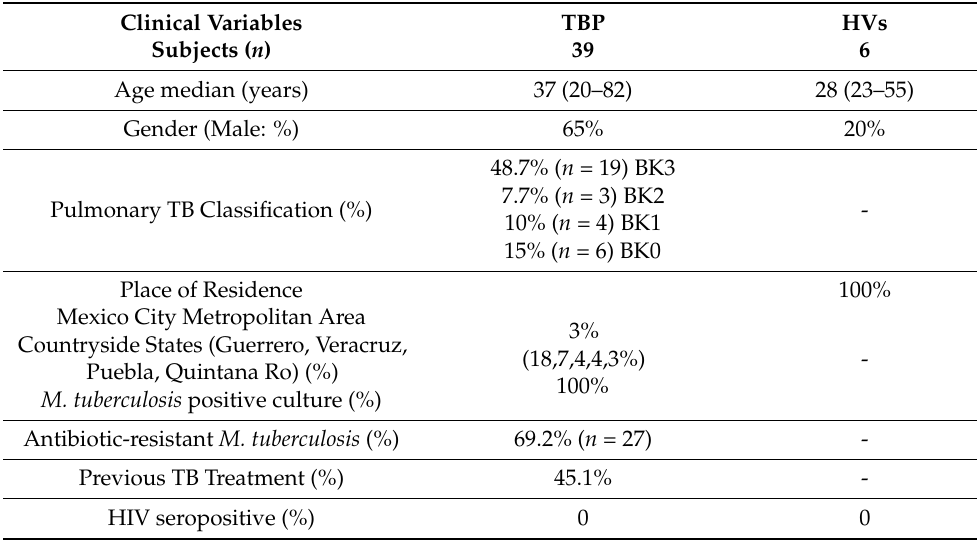
Table 1. Demographic and clinical characteristics of the study